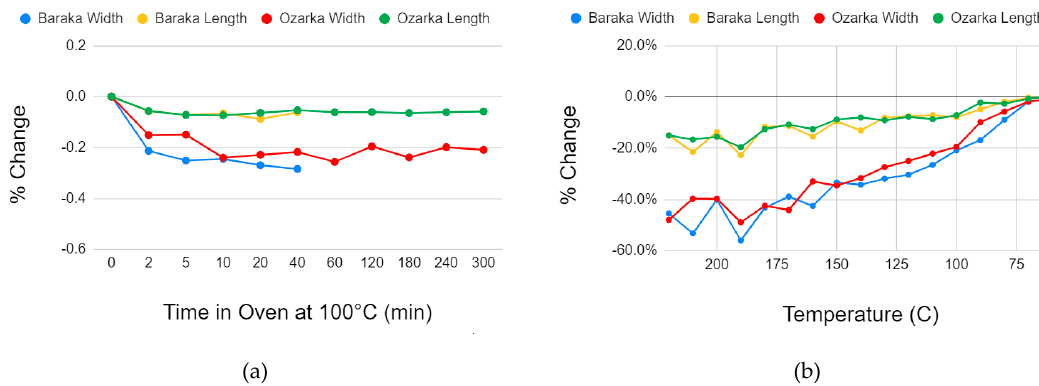
Figure 8. Effect of heating time on dimensions (width and length) of 25.4 mm squares of PET water bottle plastic heated at 100 °C ( a ) and the effect of temperature on dimensions (width and length) of 25.4 mm squares of PET water bottle plastic heated for 5 min ( b ).